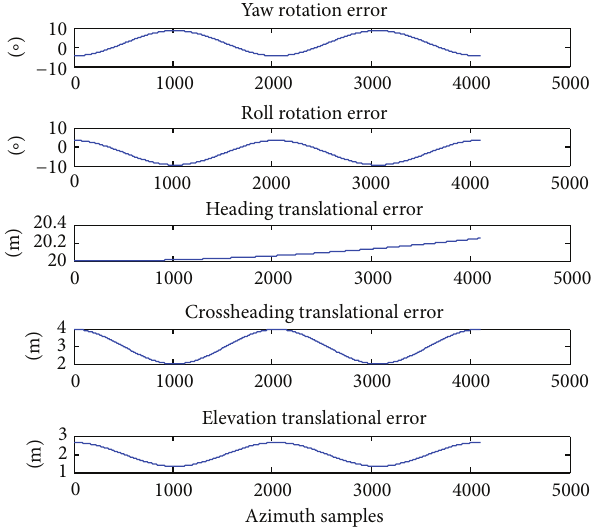
Figure 4: The simulated rotational motion errors and the transla- tional motion